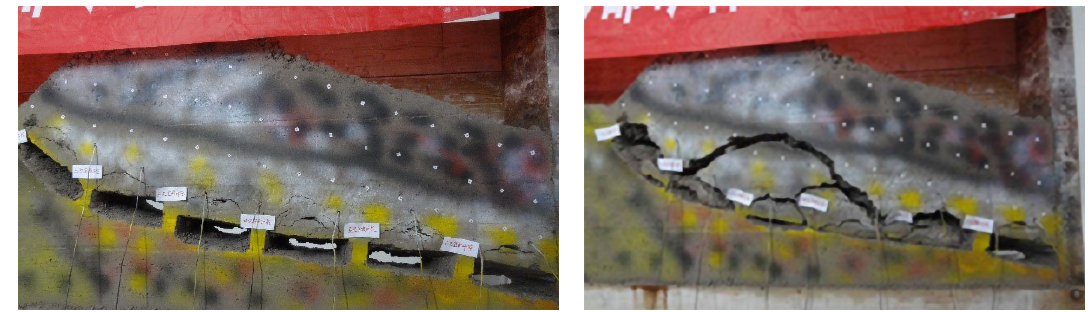
Fig. 2 Similar material simulation experiment of mining and pillar